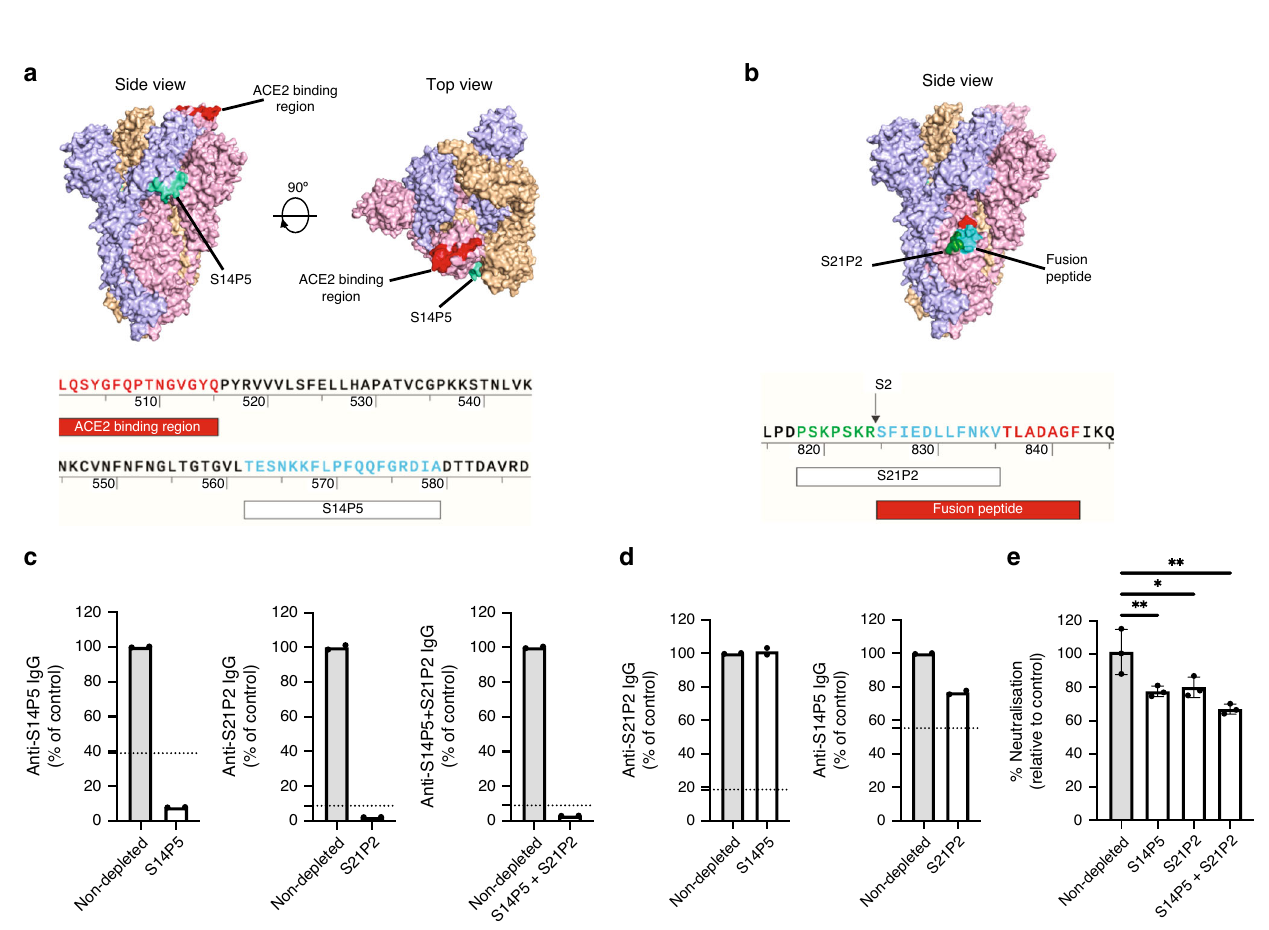
Fig. 2 COVID-19 patient sera recognise two linear epitopes in SARS-CoV-2 spike protein. a Sera of COVID-19 ( n = 6) patients at 1:1000 dilution were subjected to peptide-based IgG ELISA using peptide pools covering the entire S protein of SARS-CoV-2 in duplicates. Sera of pooled healthy donors ( n = 13) were assessed in parallel. Data are presented as mean patient OD values subtracted of healthy control value are presented, negative values are plotted as zero. b Sera of COVID-19 patients ( n = 6) were subjected to peptide-based ELISA for IgG detection using individual peptides of SARS-CoV-2 S peptide pools S14 and S21. The z score values of each patient were calculated using the formula [OD value of patient for peptide − average (OD values of patient)]/ standard deviation (OD values of patient). Data shown are from two independent experiments and presented as mean. c Serum peptide binding response of COVID-19 patients on SARS-CoV-2 peptides S14P5 and S21P2, and the corresponding regions on SARS-CoV peptides S45P3 and S51P5, respectively, was determined by ELISA at 1:1000 dilution. Statistical analysis was carried out with paired parametric two-tailed t test (* p < 0.05). d Peptides S14P5 and S21P2 response in 41 COVID-19 patients and 29 healthy controls assessed by ELISA in 1% Triton X-treated plasma fraction at 1:1000 dilution. Data are presented as mean of baseline subtracted OD of two independent experiments and was analysed by Mann – Whitney U test (*** p < 0.001). e Spearman correlation of ELISA response from 41 COVID-19 patients to individual peptides from d and sera IC 50 neutralisation against SARS-CoV-2 S pseudotyped lentiviruses (Supplementary Table 4) were shown. Line was drawn using non-linear regression with 1/ Y 2 weighting. Source data are provided as a Source Data fi le.